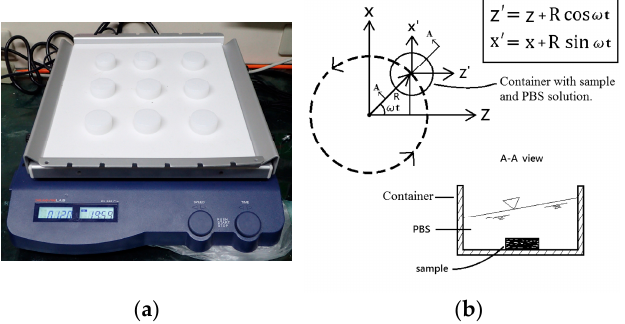
Figure 1. ( a ) The orbital shaker in this study. ( b ) The rotating path of the container, with a coated sample and phosphate-buffered saline (PBS) solution, and the relation equation of the fixed global coordinate ( X , Y , Z ) and the orbitally-moving coordinate ( X’ , Y , Z ’). ω is the rotating speed in rad/s, R is the radius of the rotating path in mm, and t is the time in seconds. The A-A view is the cross section of the container to illustrate the detailed status of the fluid.